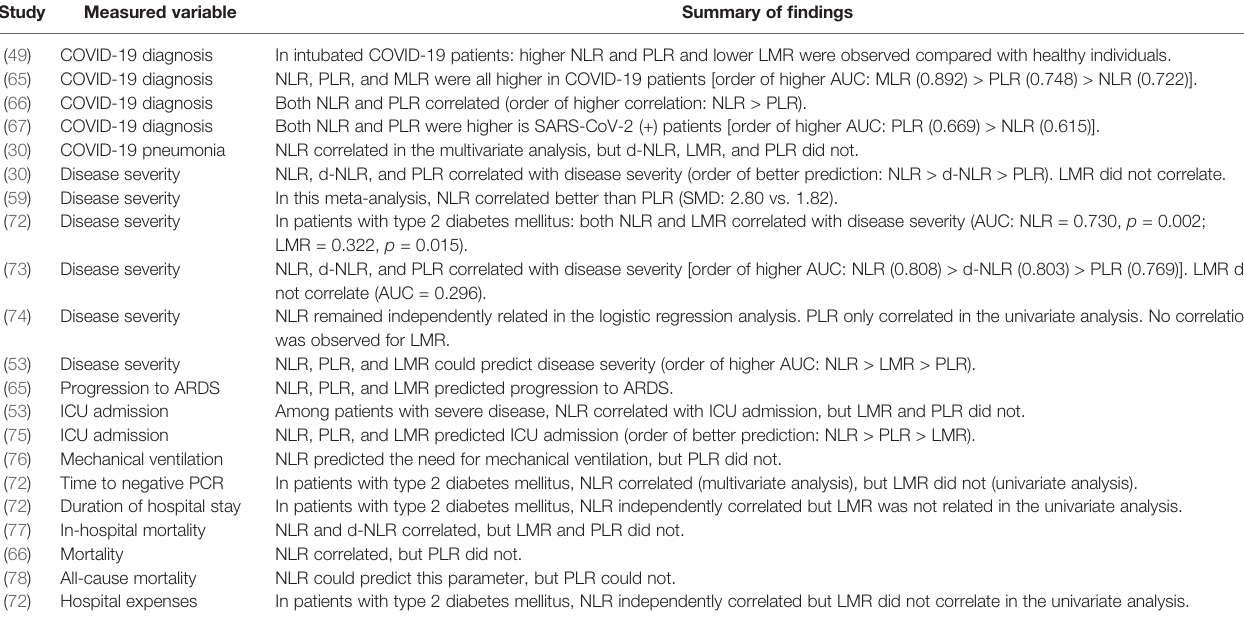
TABLE 2 | Studies comparing NLR with other biomarkers (studies involving discussed markers other than PLR, LMR, and d-NLR) among different measured variables. Study Measured variable Summary of fi ndings (68) COVID-19 diagnosis Disease severity Disease severity